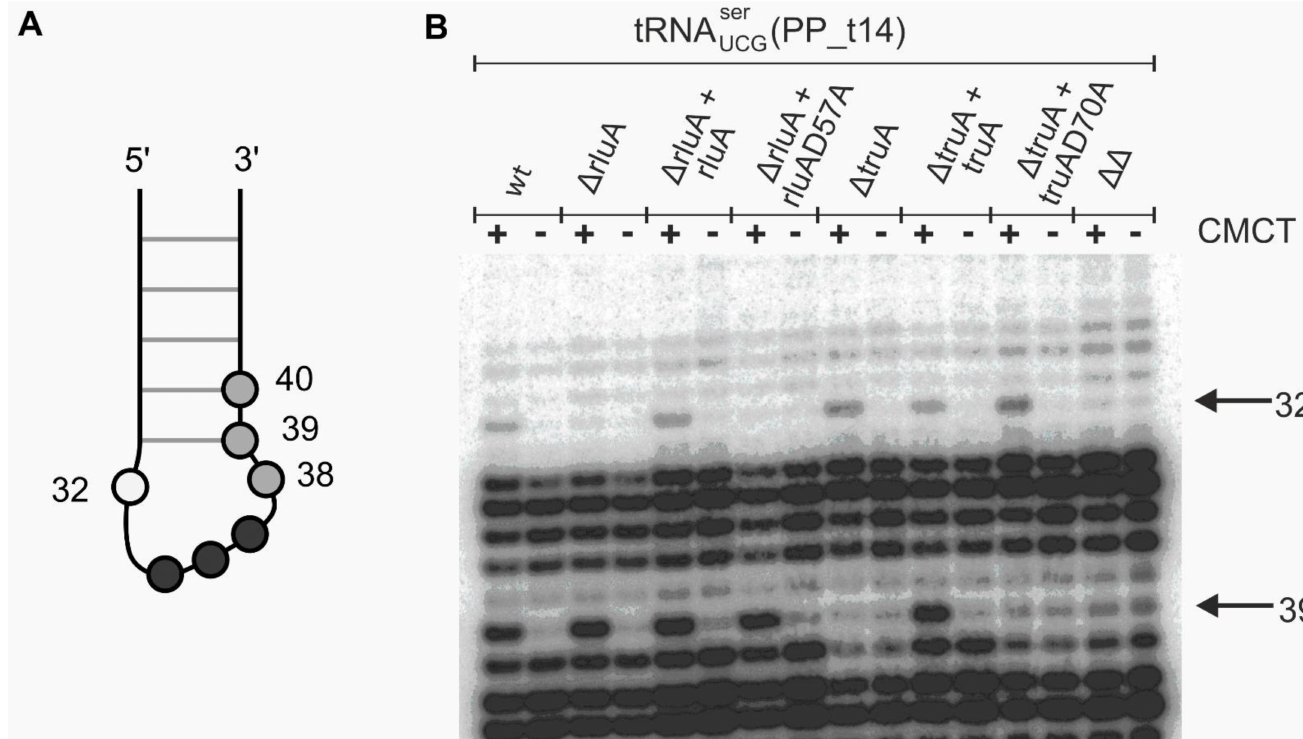
Figure 1. TruA and RluA specific pseudouridines in tRNA. ( A ) Schematic representation of tRNA anticodon stem loop (ALS) where black circles correspond to anticodon, white circle to RluA substrate position (32) and grey circles to TruA substrate positions (38-40). ( B ) Identification of TruA and RluA pseudouridylation sites in Pseudomonas putida PaW85 tRNA ser UCG in wild-type (wt) and in truA and rluA deficient mutants by CMCT/alkali and primer extension analysis. Results of truA and rluA deletion strains ( ∆ truA/ ∆ rluA), complementation strains with functional genes ( ∆ truA + truA/ ∆ rluA + rluA), complementation strains with genes encoding catalytically inactive protein ( ∆ truA + truA D70A/ ∆ rluA + rluA D57A) and truA and rluA double deletion strain ( ∆∆ ) are presented. The positions of Ψ s were identified by transcriptase-directed primer extension stops specific to CMCT/alkali treatment with tRNA ser UCG -specific primer. “+” corresponds to the CMCT-treated lane and “ − ” to the untreated tRNA. The target positions of TruA (39) or RluA (32) in tRNA are indicated by